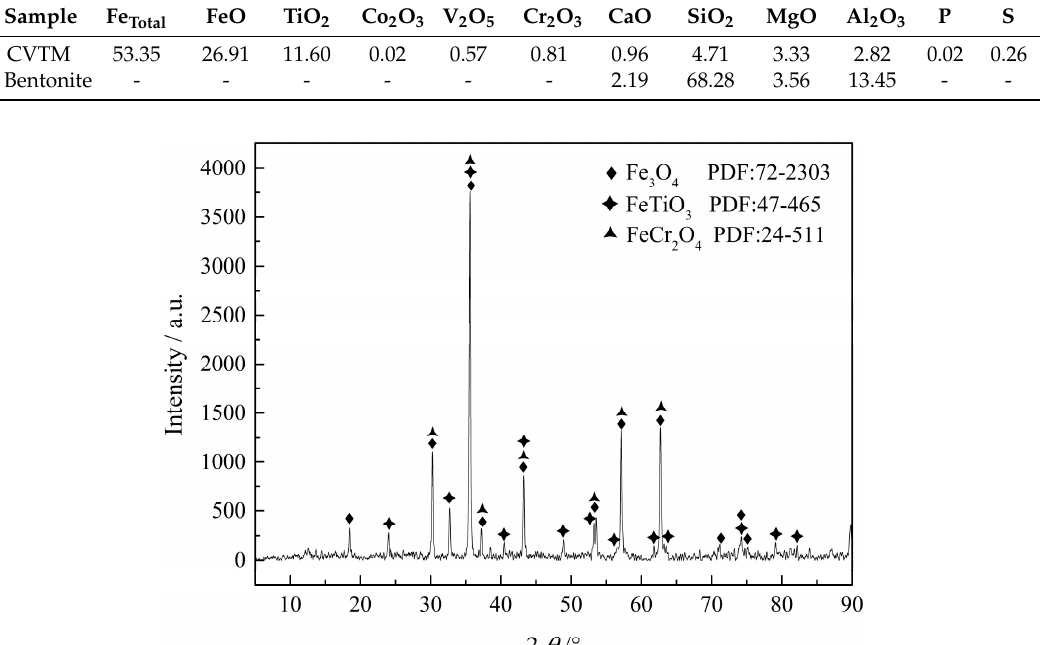
Table 1. Chemical compositions of raw materials (wt %).